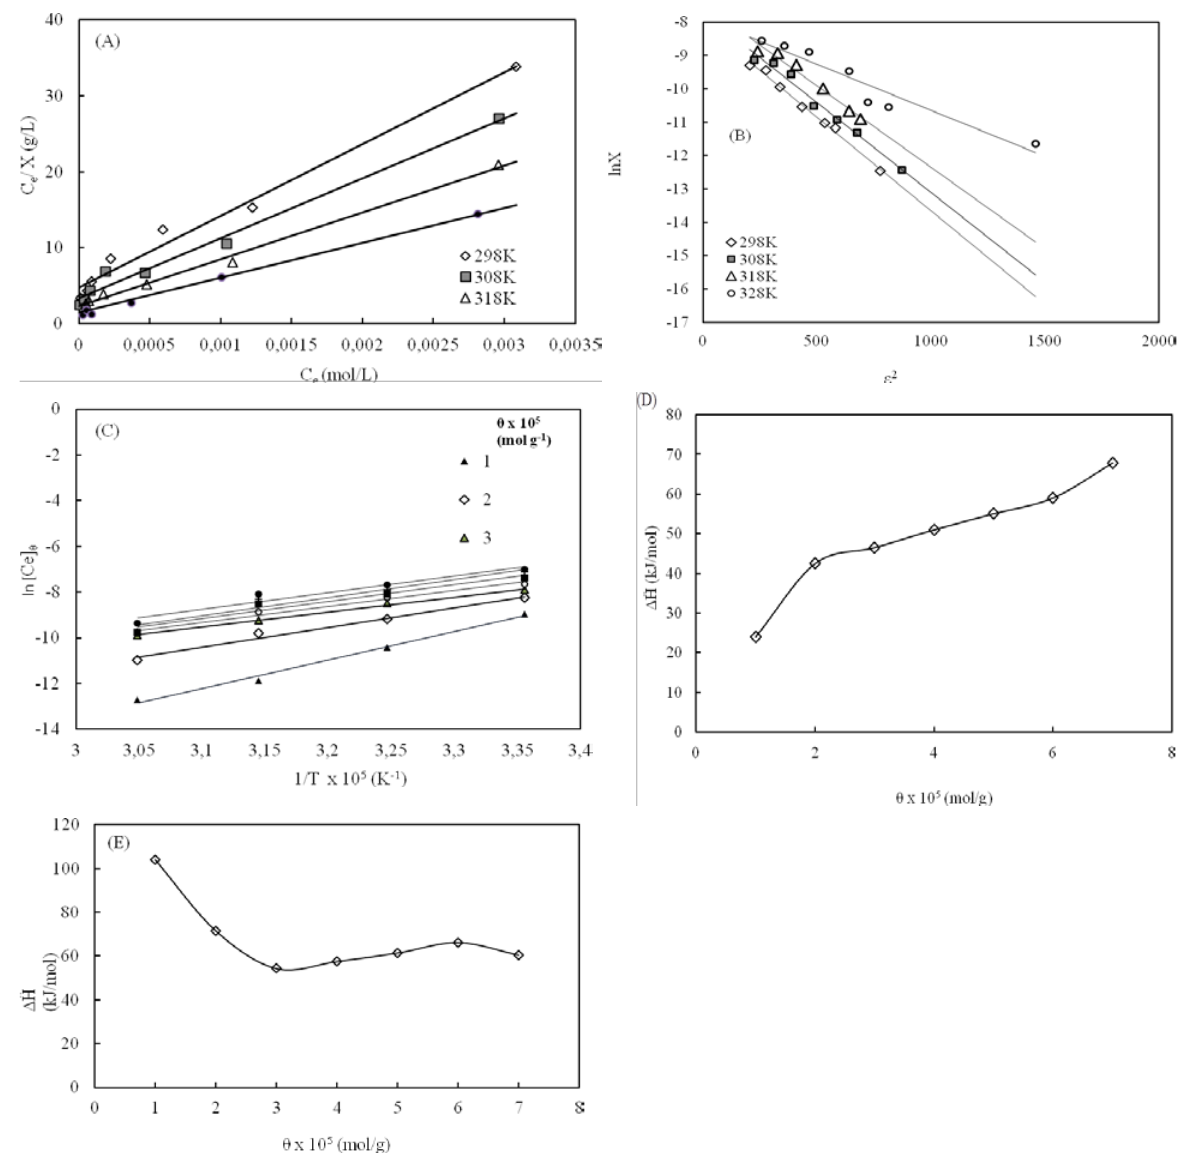
vs. T -1 , Isosteric heat of adsorption (∆ ) vs. surface θ O and (E) nano -powder Fe O . 2 3 2 3